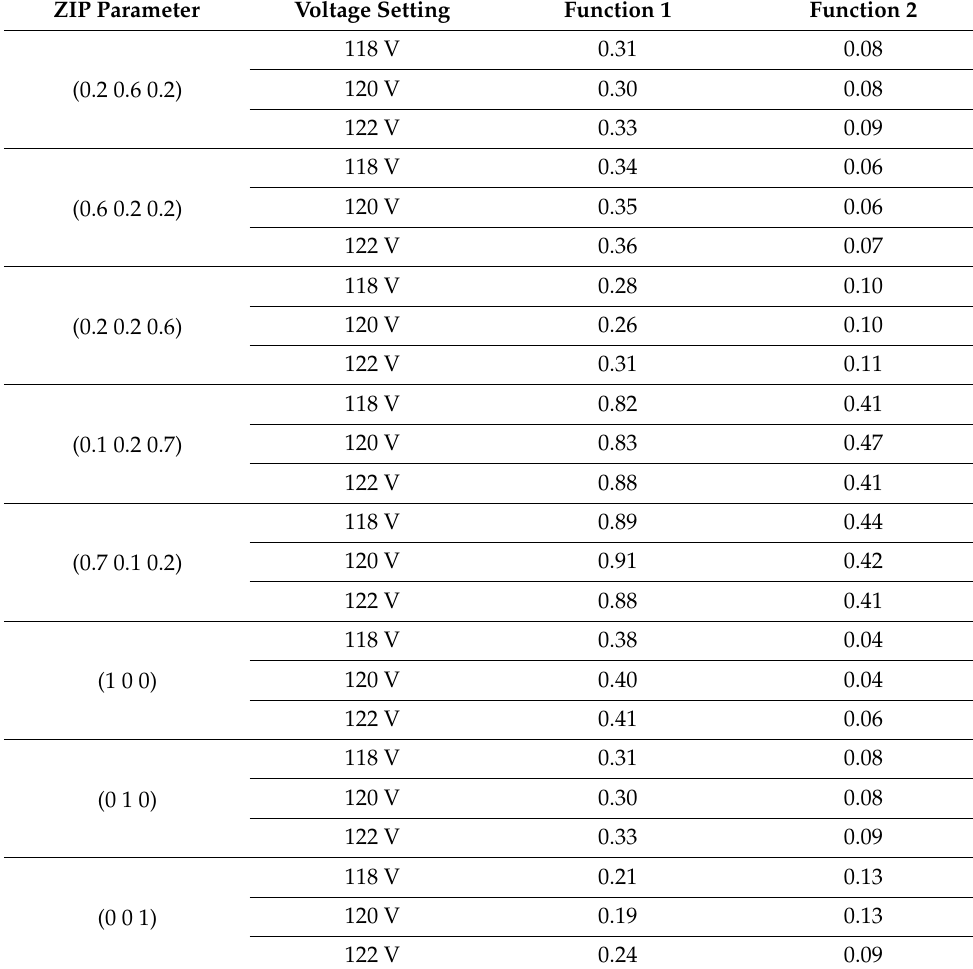
Table 9. RMS error for active power loss estimation for function 1 and 2 for IEEE-13 bus